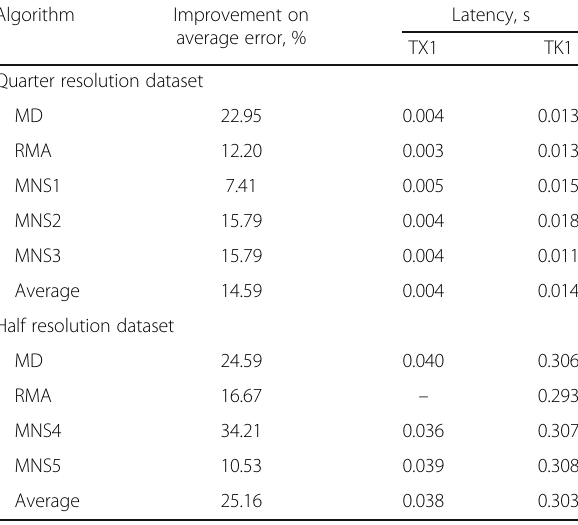
Table 7 Average error improvement after applying suggested post-processing, i.e. median blur filter. Post-processing significantly improved produced results. The added computation time was not significant. We performed the tests using only our proposed algorithms on the two Middlebury training sets images Algorithm Quarter resolution